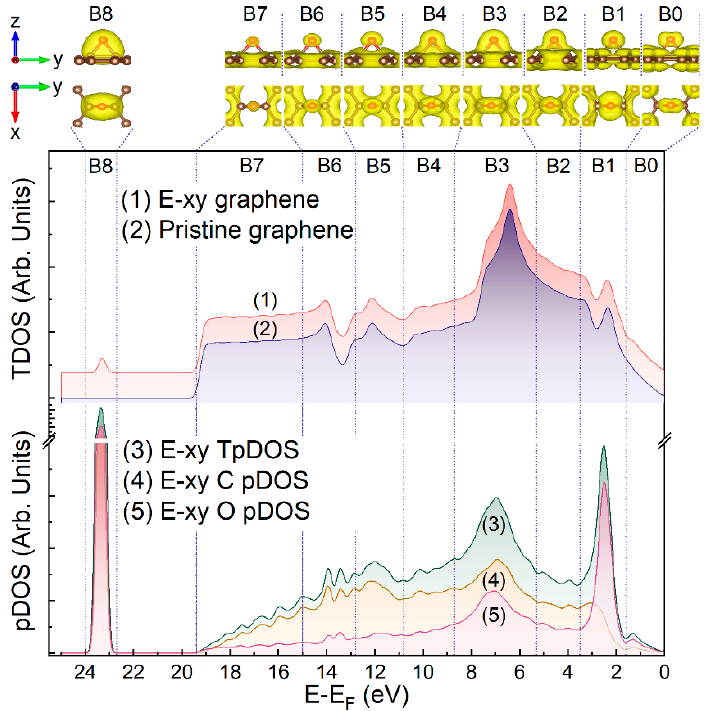
Figure 5. The calculated DOS of the E-xy graphene, pristine graphene layer, C pDOS, O pDOS, and TpDOS, and images of the electron distribution for the epoxide group on the graphene layer.